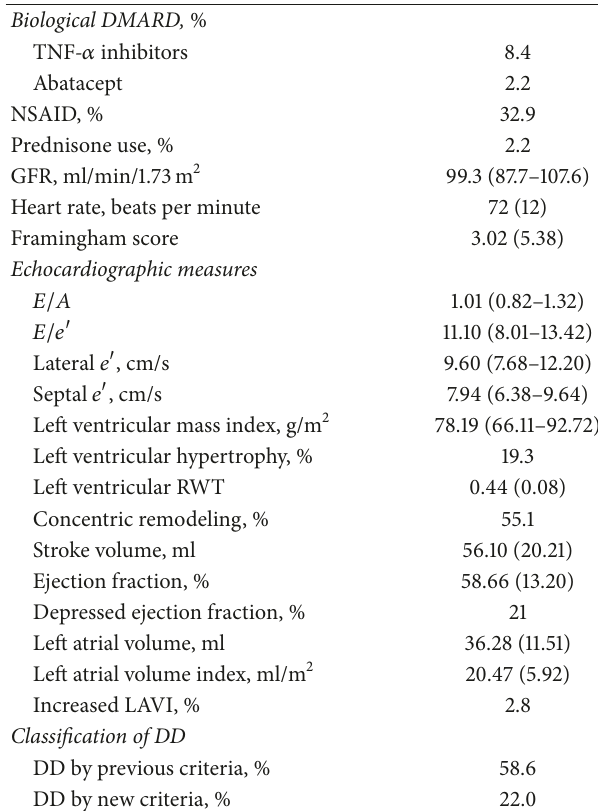
Table 1: Recorded characteristics in 176 patients with